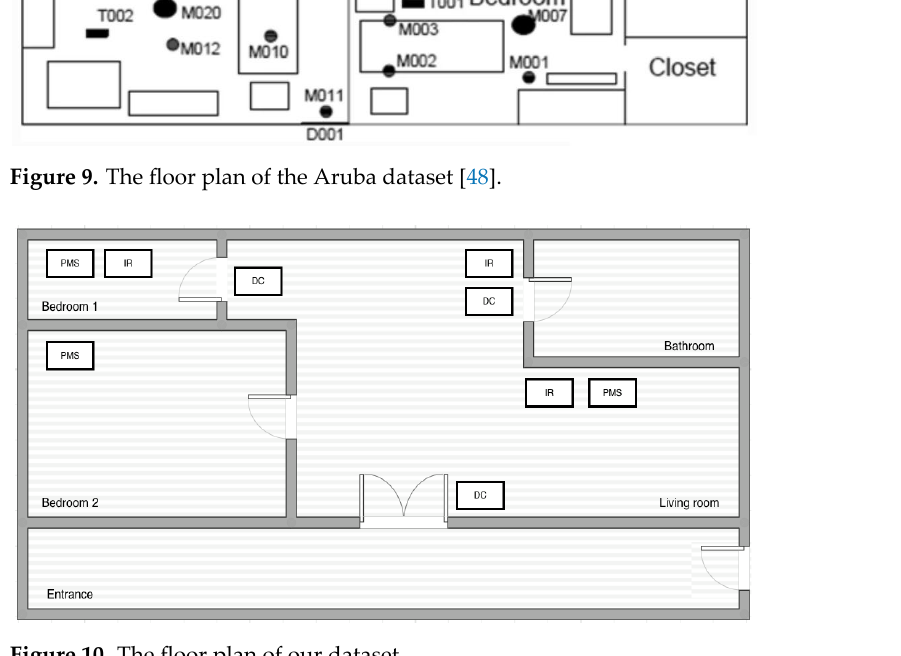
Figure 10. The floor plan of our dataset.